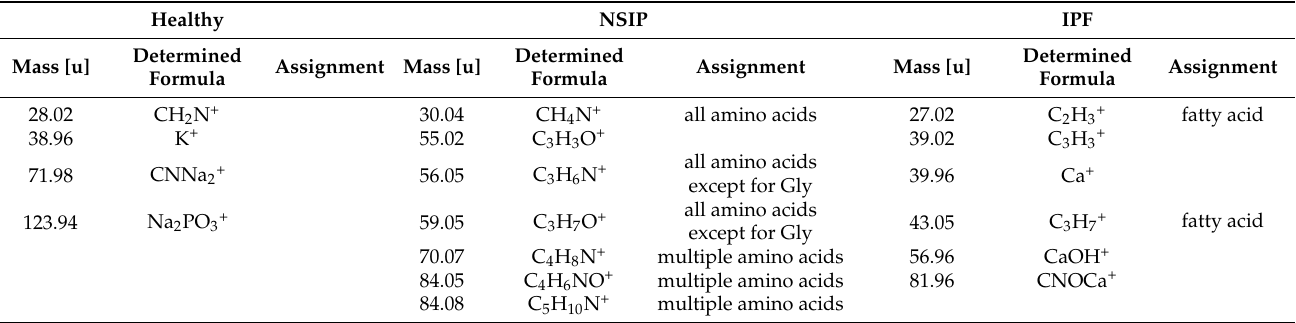
Table 3. The most characteristic ToF-SIMS signals for each cell line (Procedure II), revealed by loadings plot